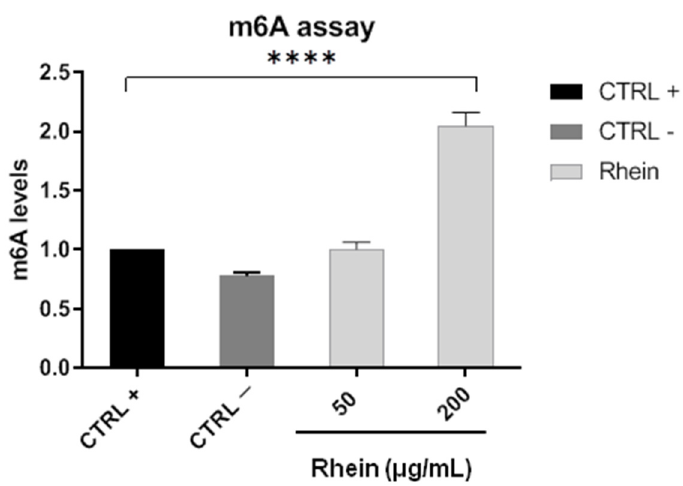
Figure 3. RNA m6A quantification. Cells were co-exposed to rhein and SARS-CoV-2, and total RNA was collected after 48 hpi. The values are the mean ± SD of three independent experiments. The levels of statistical significance are indicated as follows: **** p < 0.0001. CTRL+: not infected cells; CTRL − : infected cells.